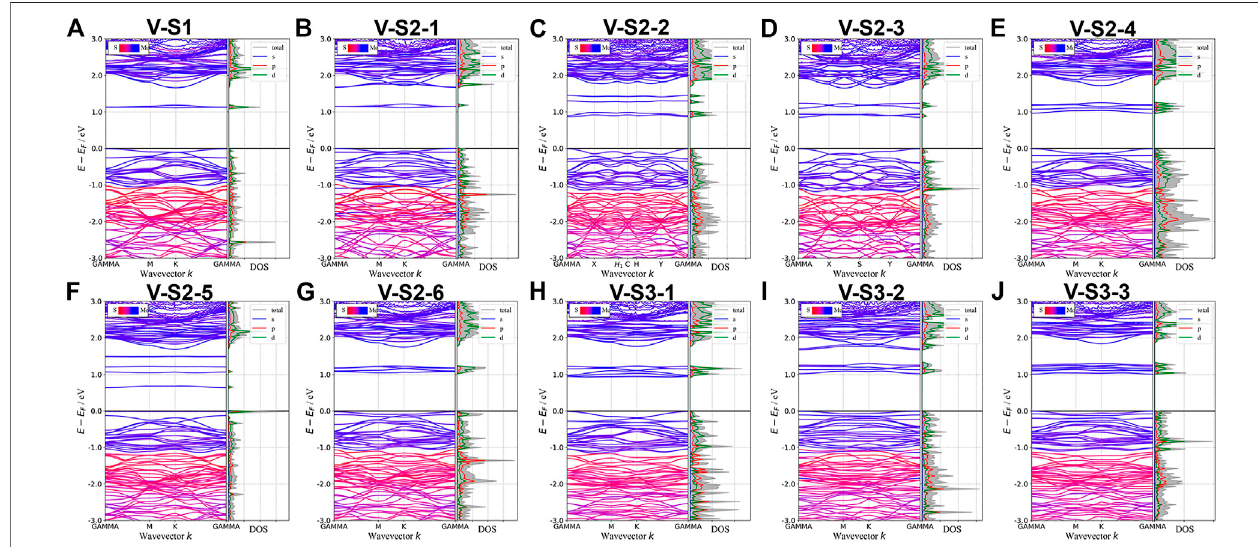
FIGURE5| BandstructuresandpDOSofmonolayer2H-MoS 2 withdifferentS-vacancydefects.Thelabelsofdifferentvacancystructuresaredenotedaboveeach fi gure. The corresponding atomic con fi gurations can be referred to Figure 4 .